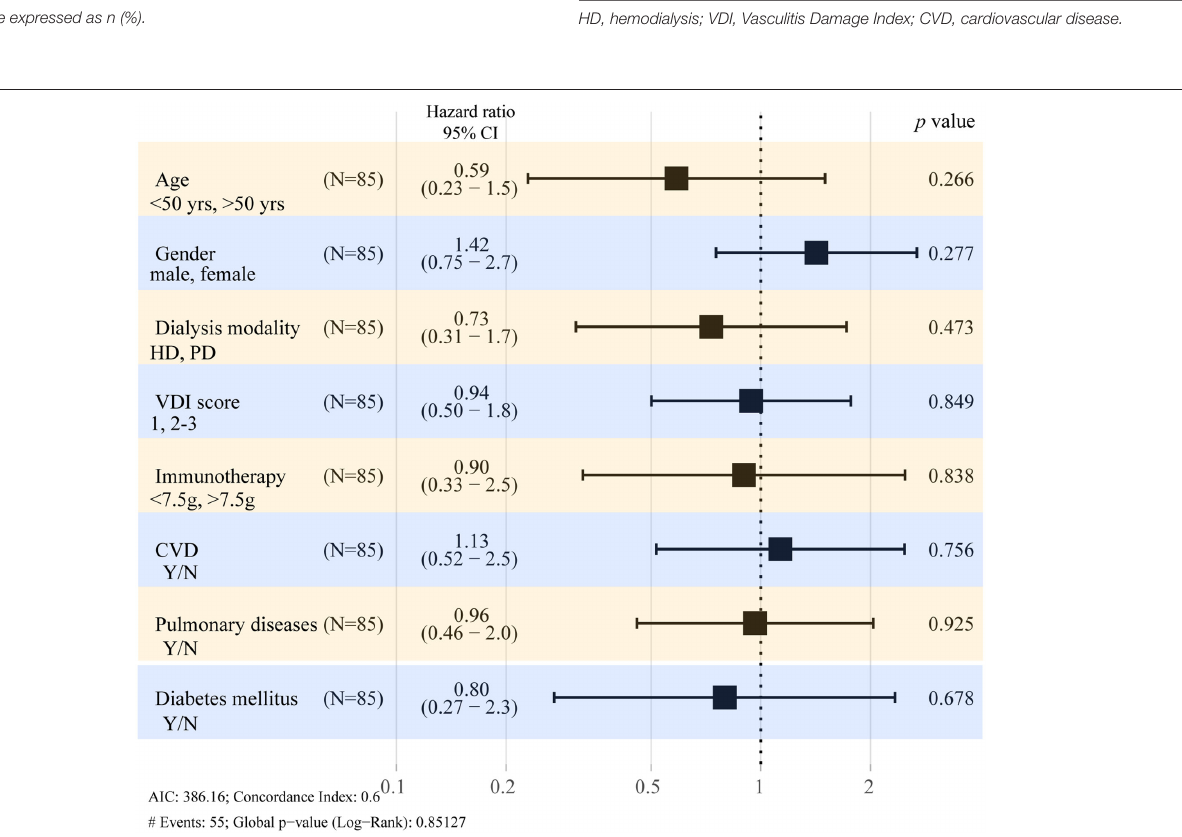
Frontiers in Medicine |